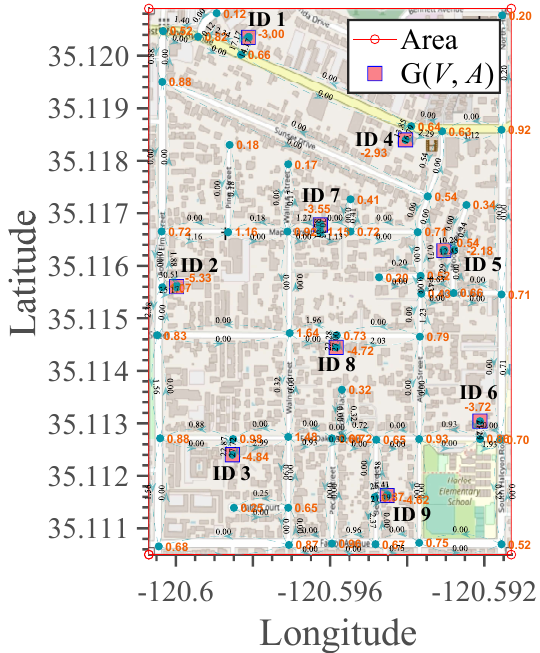
Figure 11. Case B: Graphical solution to the multiple-product problem. A fundamental condition for the convergence of the model is that the supply centers with a negative sign cover the demand with a positive signal at each intersection. This condition is critical to maintaining the nodal equilibrium criterion, which satisfies the equations in the mathematical problem statement. The red negative sign indicates the flows that will have to be served by each charging station; let us remember that the negative sign indicates that it is a supply node (charging